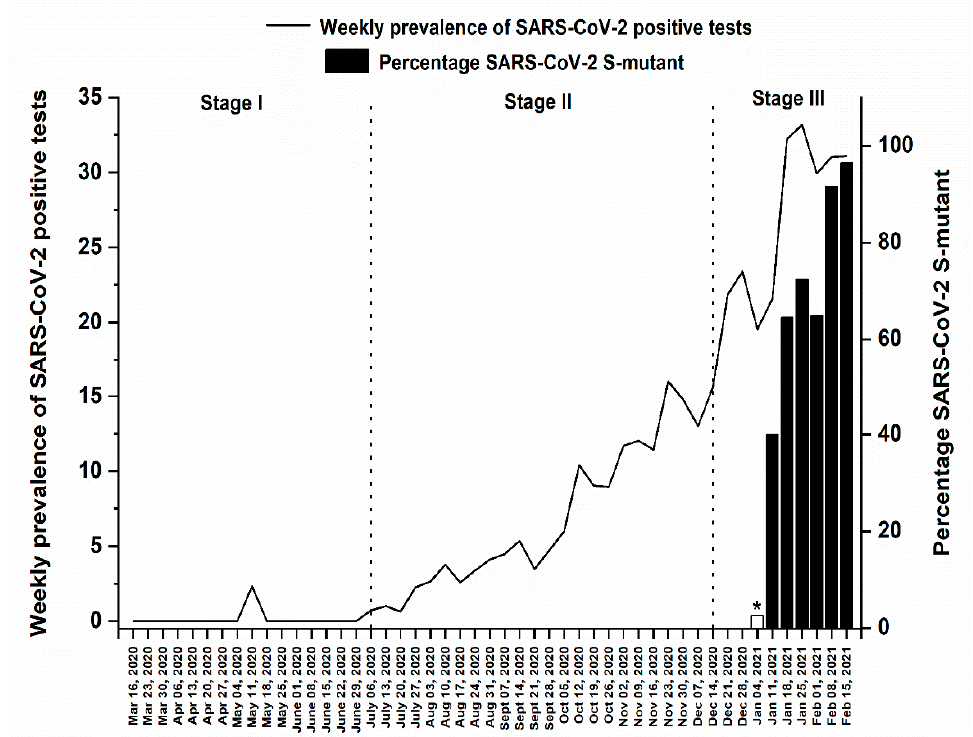
Figure 4. Weekly prevalence of SARS-CoV-2 positive tests and the percentage of S -mutant variant(s) among SARS-CoV-2 positive cases between 16 March 2020 and 21 February 2021. *Missing data.